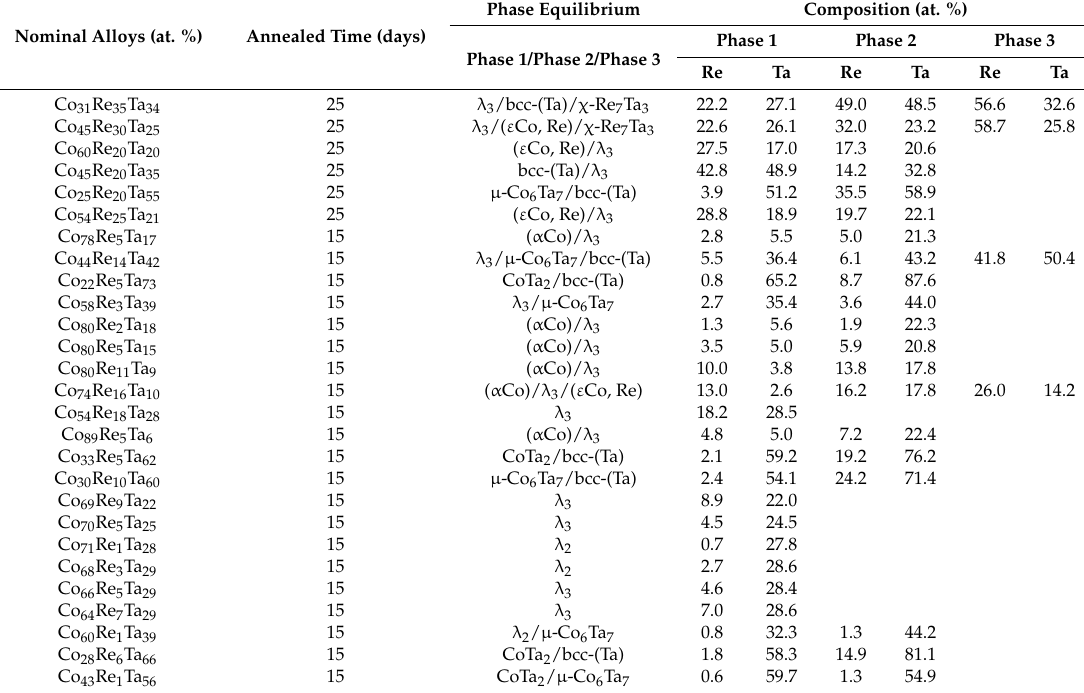
Table 4. Equilibrium compositions of the Co-Re-Ta ternary system at 1300 ◦ C as determined in the present